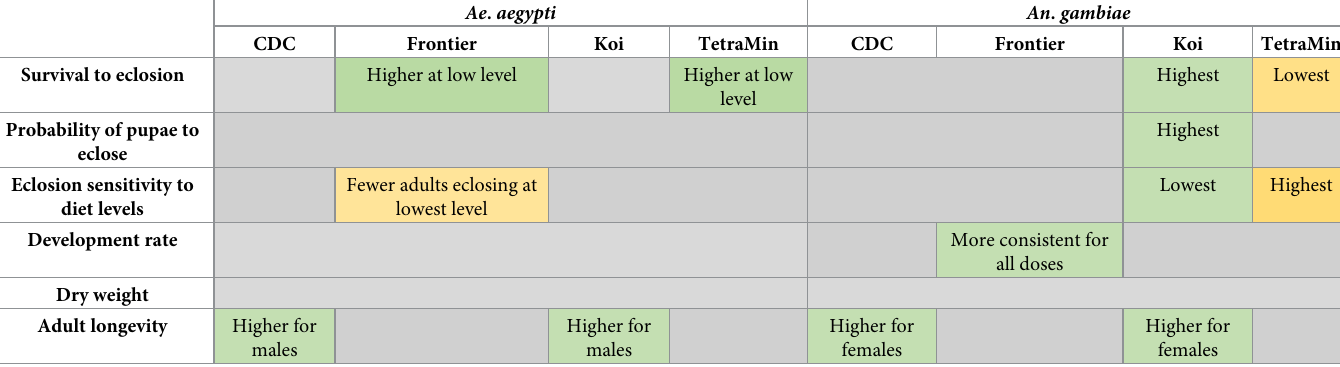
Table 9. A semi-subjective assessment of the salient biological outcomes measured as an assessment of laboratory use of the four diets tested (advantageous charac- teristics are highlighted in green, neutral ones in gray and disadvantageous ones in